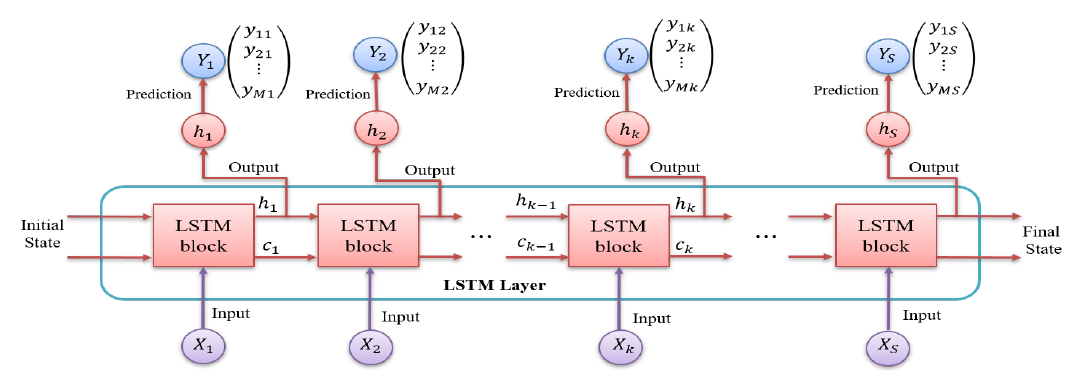
Figure 9. Architecture of LSTM network for regression.